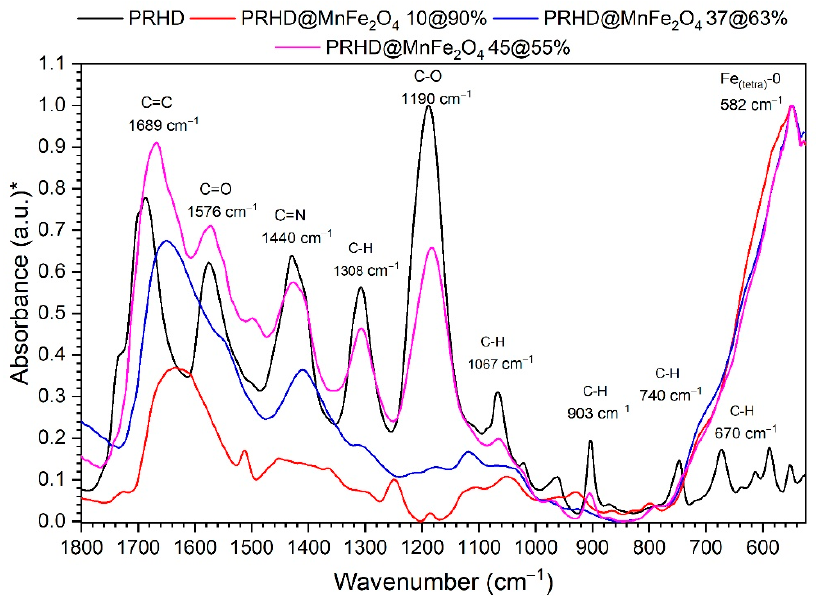
Figure 4. FT-IR-ATR spectra of the reference PRHD (red line) and hybrids PRHD@MnFe 2 O 4 . (*) normalized absorbance for comparison purposes.